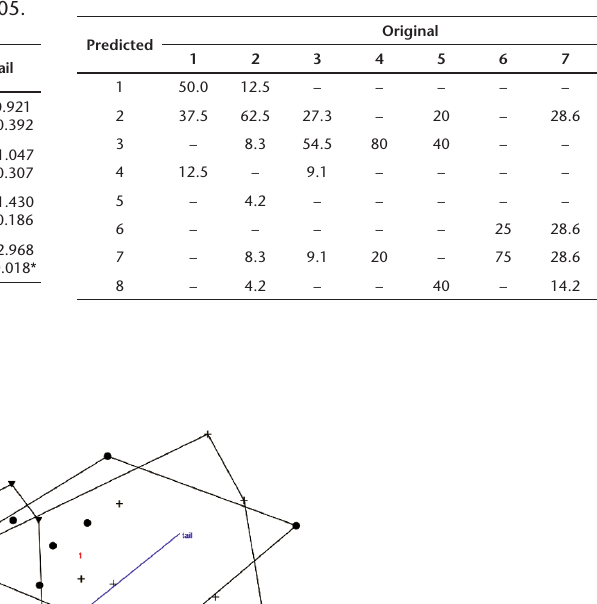
Table 4. Frequency of percentages of predictive performance from the Lineal Discriminant Analysis (LDA) for all the geographic groups.